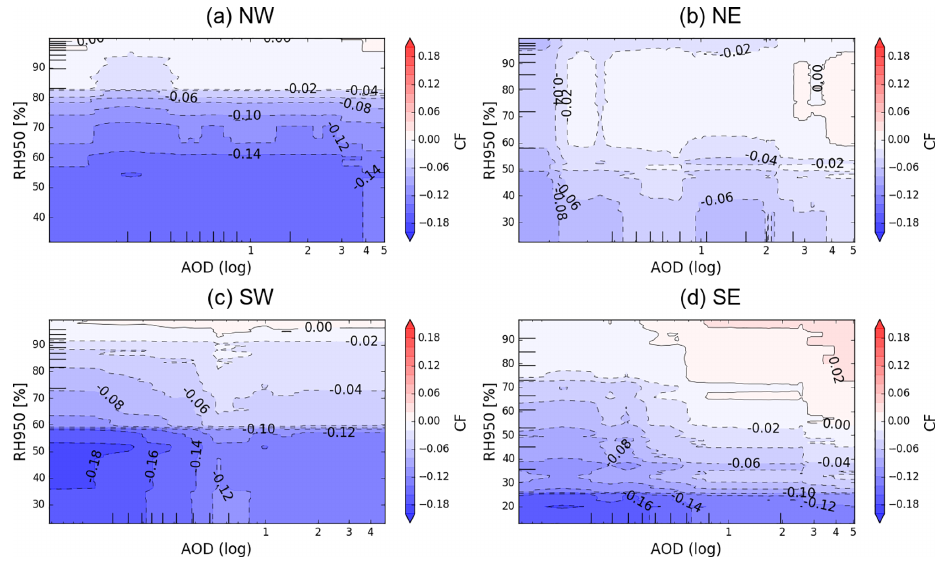
Figure 10. Two-variable partial dependence of CF on RH950 and AOD in the four subregions NW (a) , NE (b) , SW (c) and SE (d) during JAS. Description as in Fig. 5.